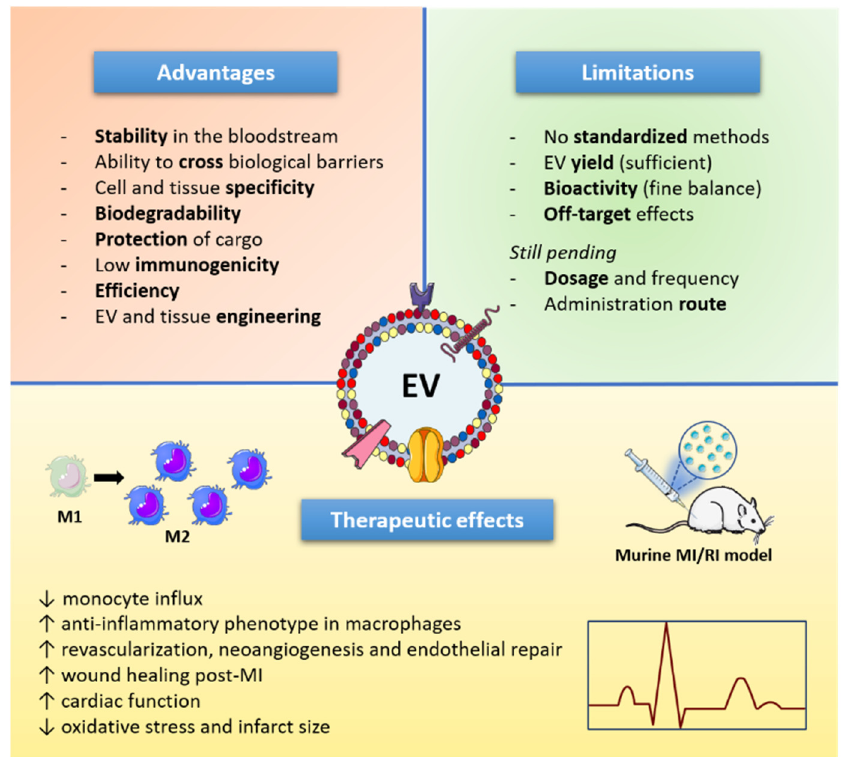
Figure 1. Schematic summary of extracellular vesicles (EVs) as therapeutic tools. EV indicates extracellular vesicle; MI, myocardial infarction; ↑, increase; ↓ decrease .